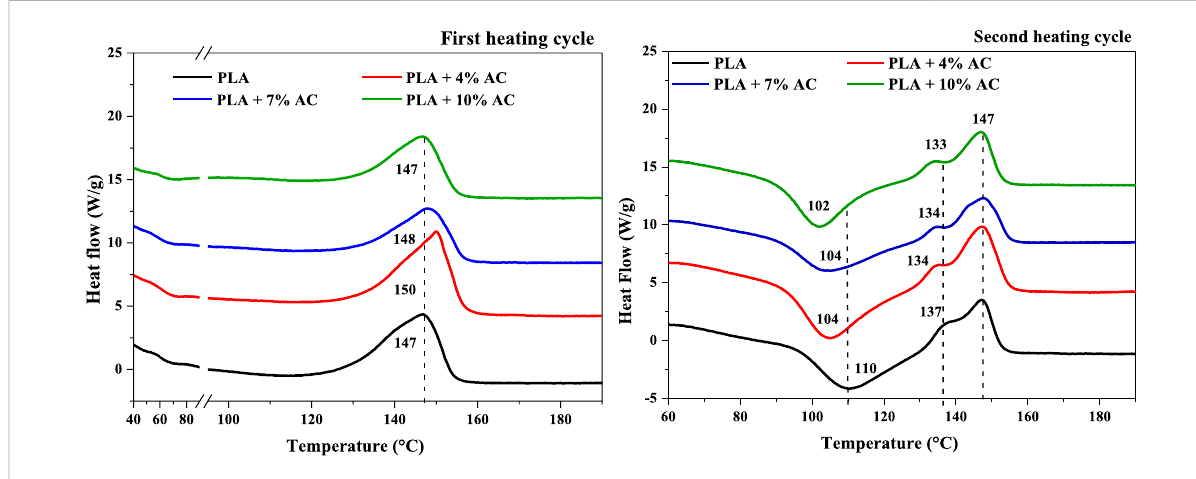
FIGURE 8 DSC thermograms for PLA and PLA/AC composites during the fi rst and second heating.